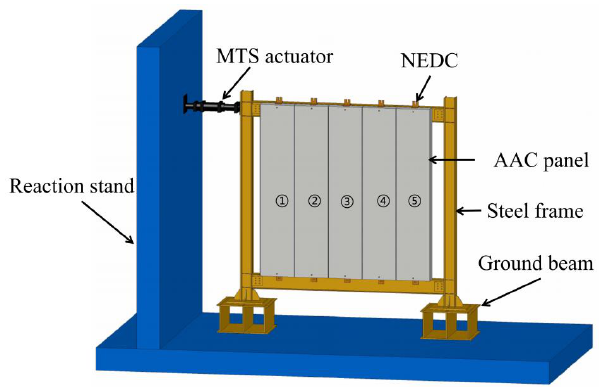
Figure 9. Diagram of the loading device used.